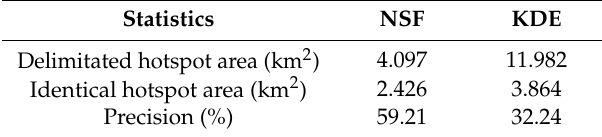
Table 1. The evaluation of the NSF and KDE methods in terms of a precision